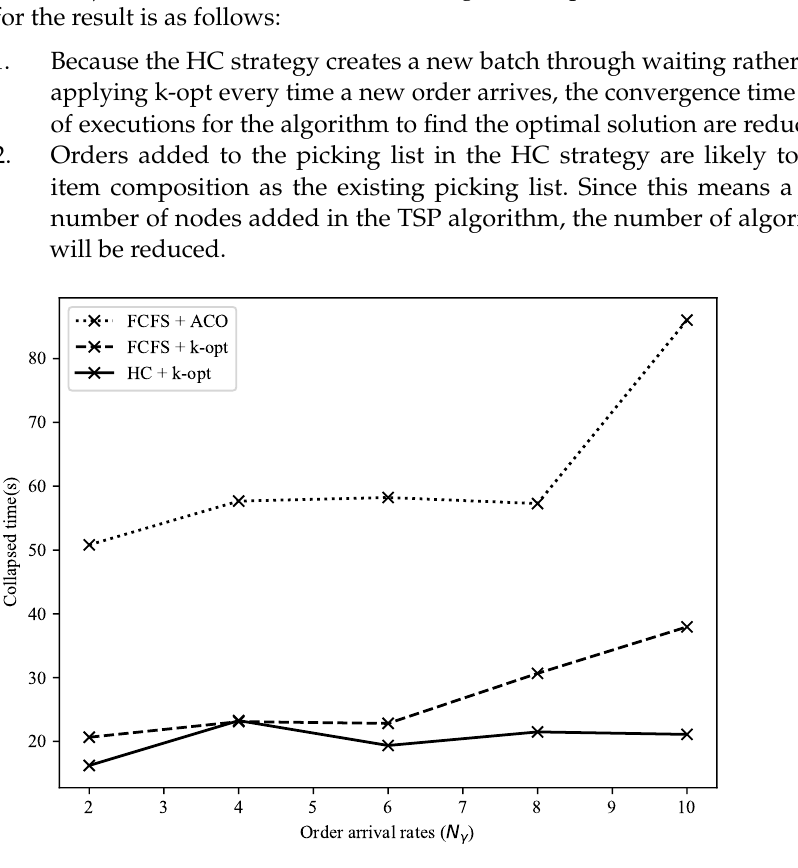
Figure 8. A comparison graph of the collapsed time for the order arrival rate. This algorithm time is the sum of the order sequencing time and the batch generation time of the